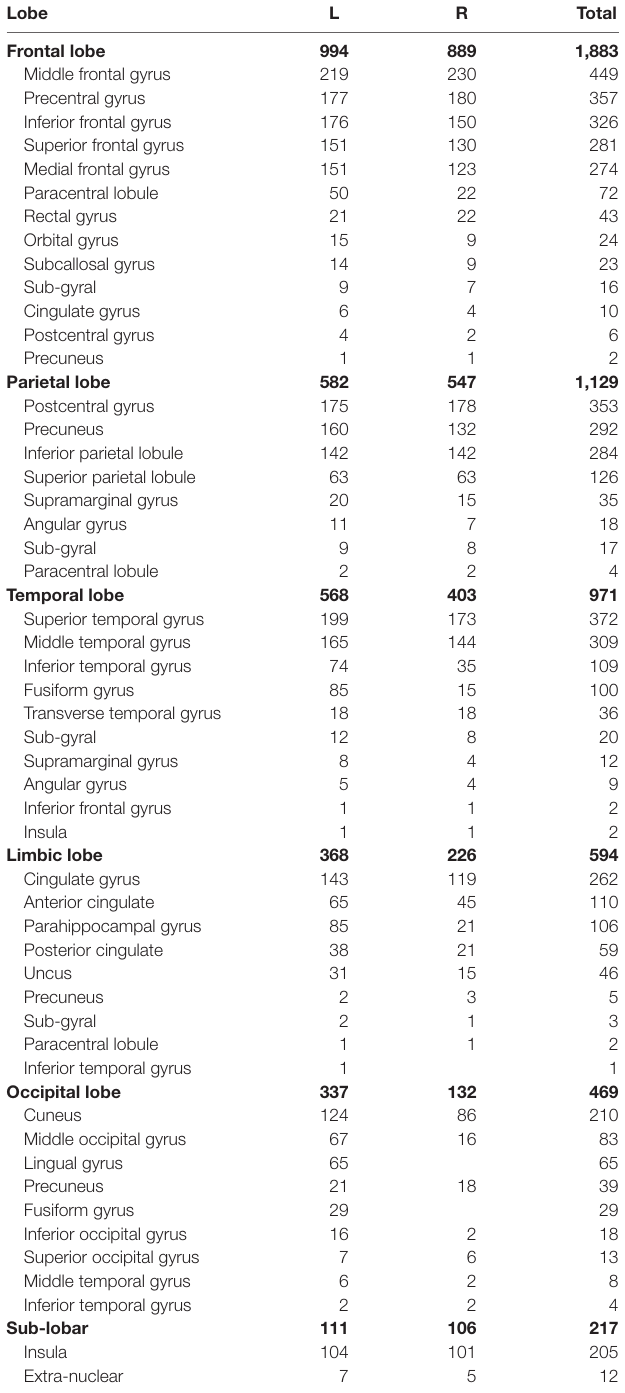
TABLE 2 | Significant brain regions of P1 source activities and the numbers of voxels differing between VM patients and HC subjects. Lobe L R Total Frontal